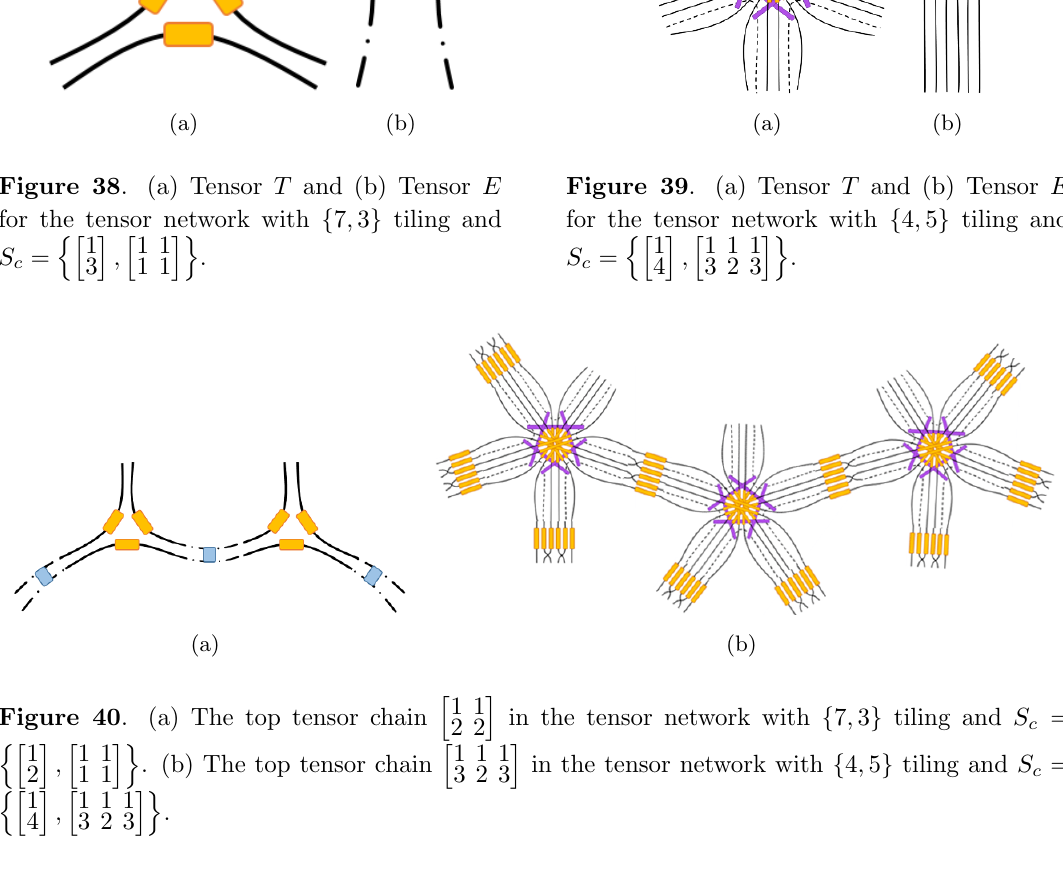
Figure 40 . (a) The top tensor chain nh 1 i h 1 1 io ; . (b) The top tensor chain 2 1 1 nh 1 i h 1 1 1 io ; 4 3 2 3